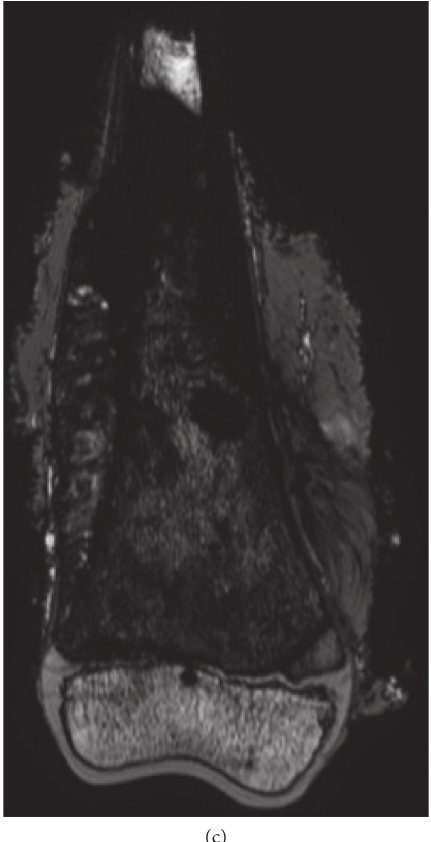
Figure 3: An 11-year-old boy with distal femur osteosarcoma. No PSI was used because 17.5cm bone resection was necessary for a growth prosthesis. One margin was measured. (a) T1-weighted MRI; (b) macroscopic cut; (c) T2-weighted MRI.